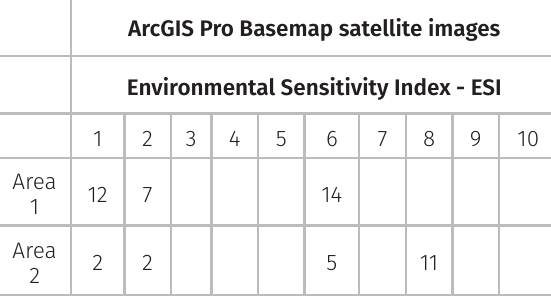
Figure 3. ArcGIS Pro Basemap satellite image with the interpreted Environmental Sensitivity Index (ESI) mapping for oil spills. Area 1 represents the “Praia da Lagoa” Beach rocky shore, and Area 2 represents Cocanha Island rocky shore.